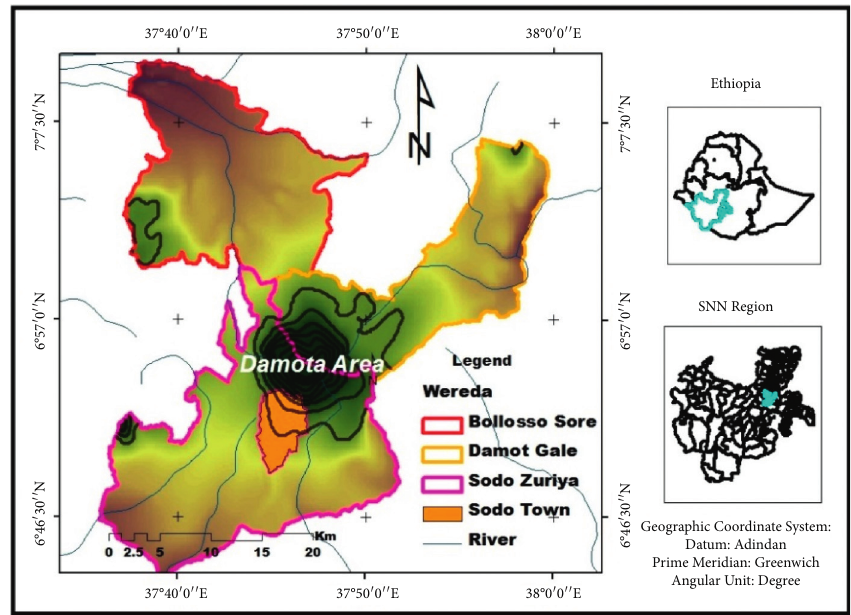
Figure 1: Location map of Damota area